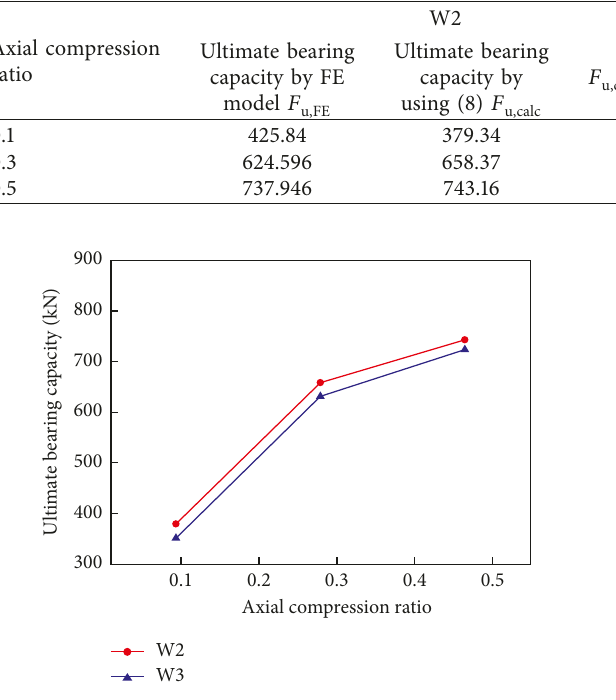
Figure 30: Variation of the calculated ultimate bearing capacity with axial compression ratio.